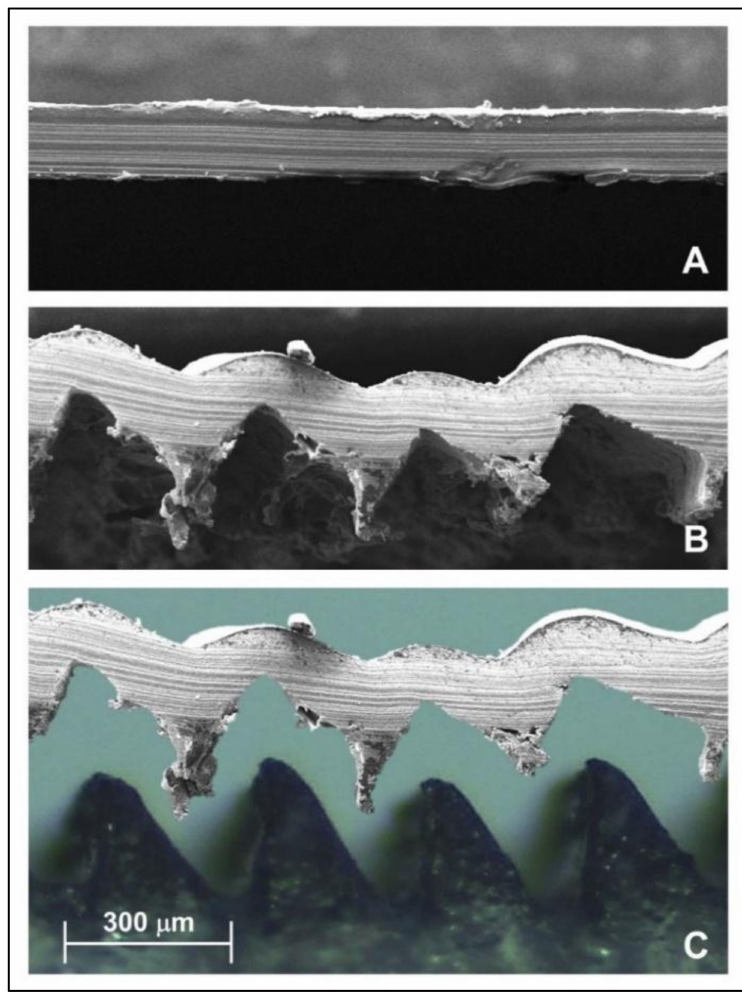
Figure 2. Microscopy of the films (scale bar 300 µ m). ( A ) Scanning electron microscopy (SEM) image of the flat film. ( B ) SEM image of the microstructured film. ( C ) Photomontage between an optical image of the microstructured mold and a SEM image of the microstructured